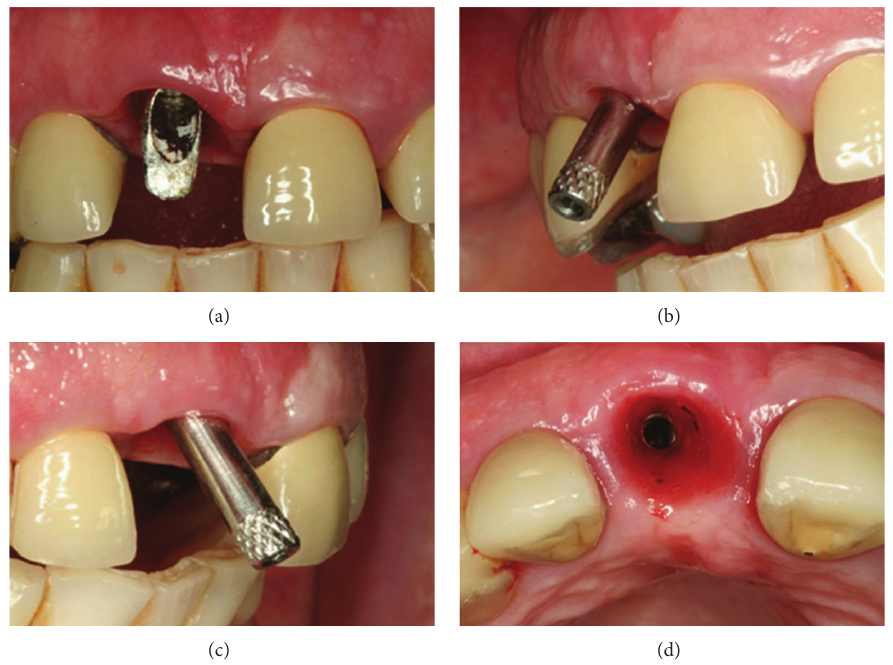
Figure 2: Clinical examination showing buccally implant